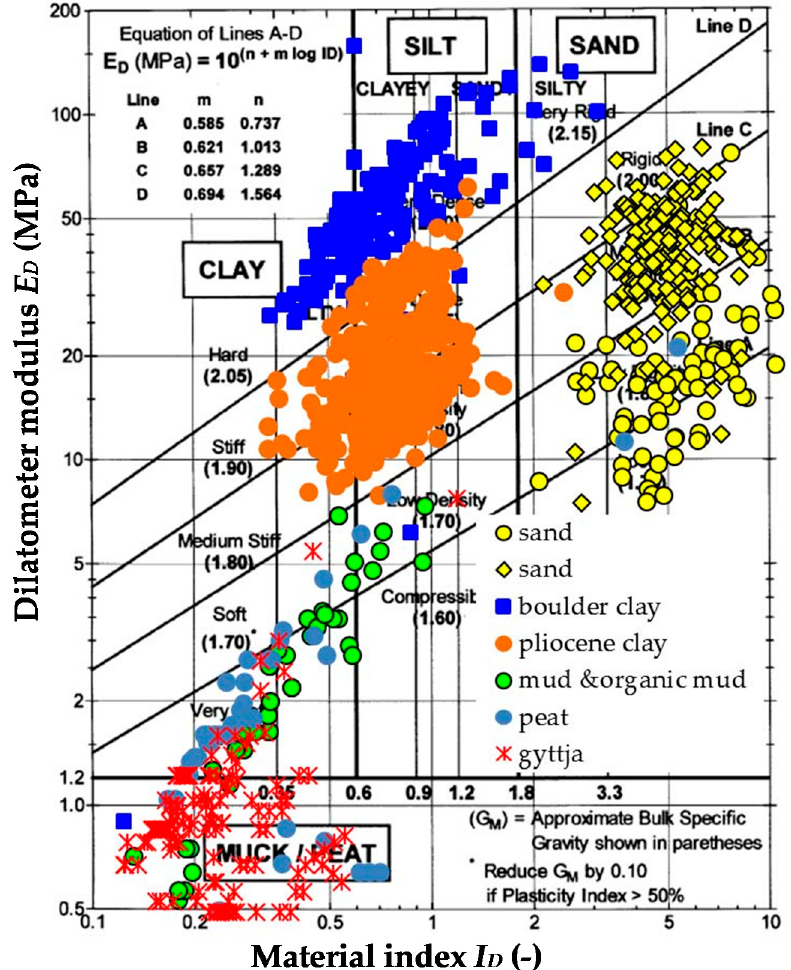
Figure 9. Chart for estimating soil type and unit weight (normalized to γ w ) [2].